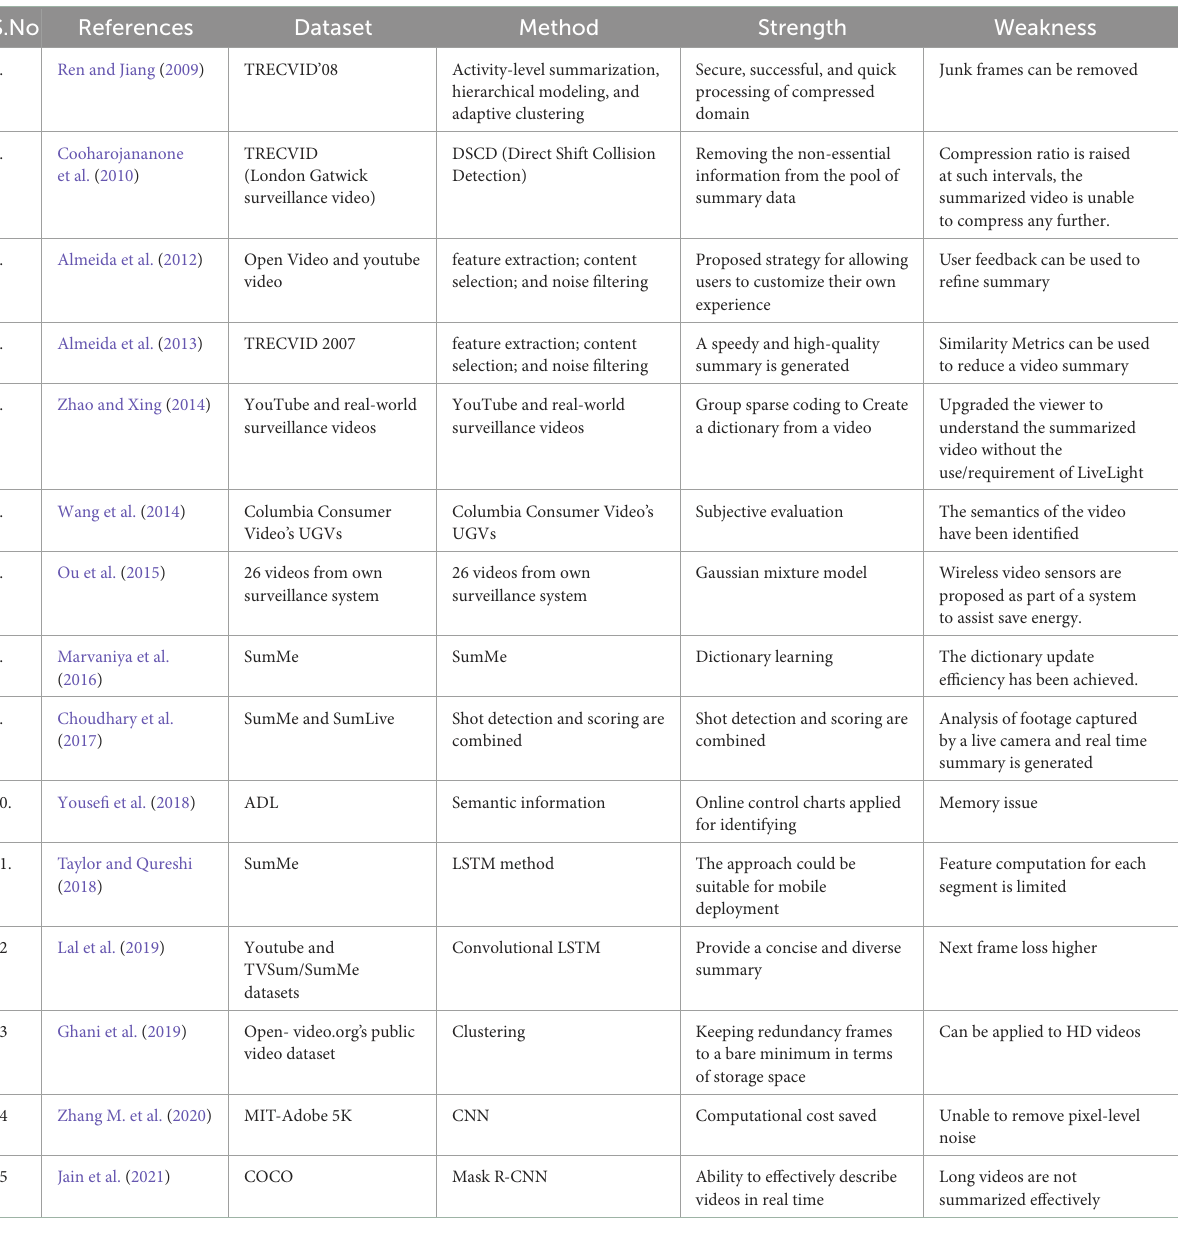
TABLE 2 Prominent studies on real time or online summarization.